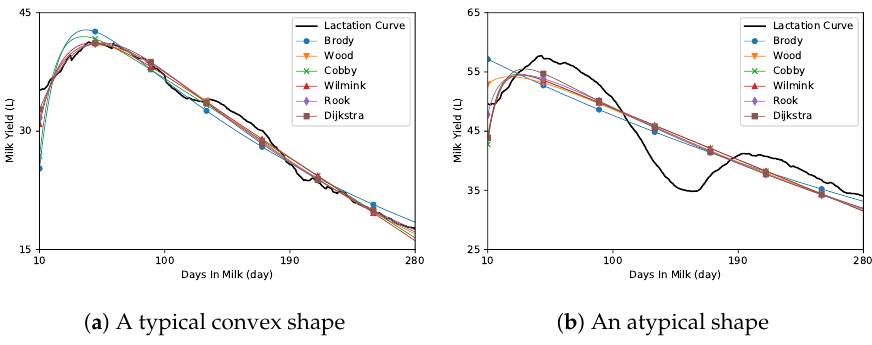
Figure 1. Approximated LCs of the models listed in Table